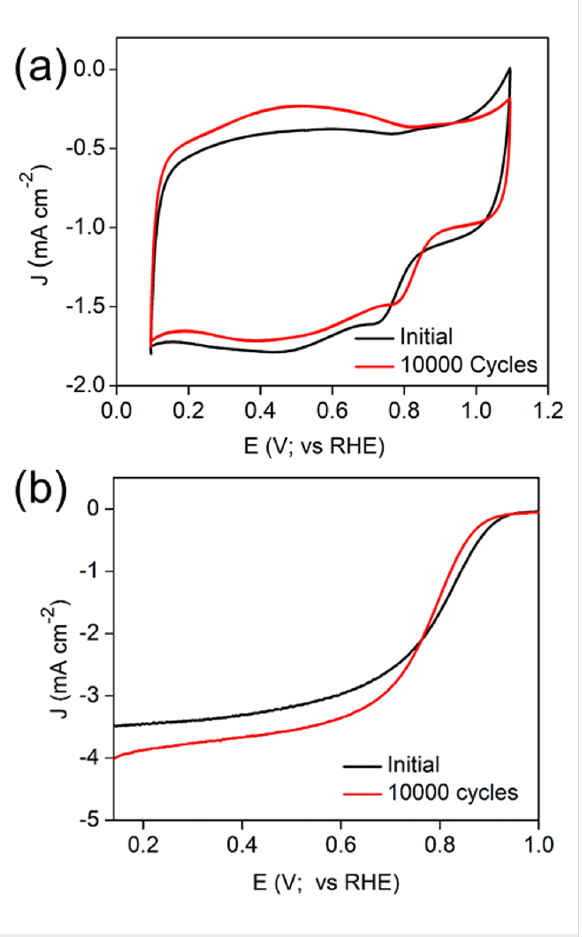
Figure 7: Stability of ACC-2. (a) CV curves and (b) LSV curves before and after 10,000 continuous cycles in O 2 -saturated 0.1 M KOH elec-